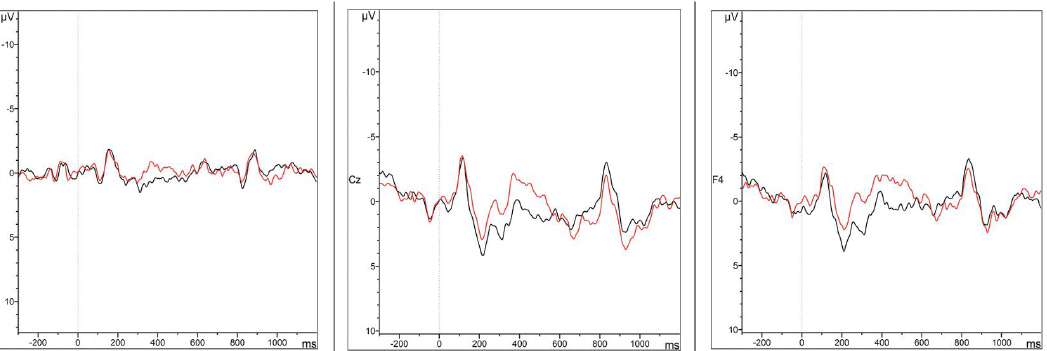
and best fit model included random intercepts for participants and items, but random